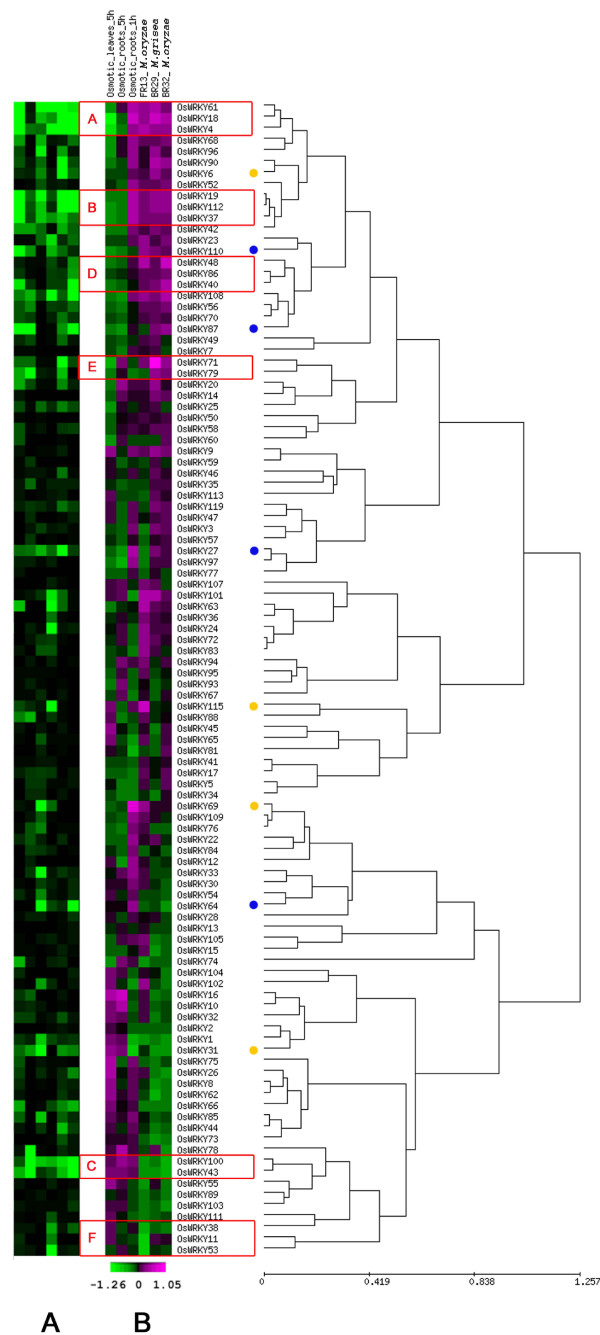
Clustering of OsWRKY genes according to their expression profiles in the OsWRKYARRAY. The OsWRKYARRAY was constitued of 104 probesets representing all members of the rice WRKY gene family. The expression of the 104 OsWRKY genes was assessed upon inoculation with Magnaporthe oryzae isolate from rice (FR13), M. oryzae BR32 from wheat, M. grisea BR29 from crabgrass and upon application of osmotic stress (mannitol) in hydroponic conditions. Panel A T-test P-values (shown by a green - black gradient) of treated vs control of the corresponding ratios shown in Panel B. The range of log transformed P-values comprised values between 0.01 (green) and 1 (black). P-values lower than 0.01 were visualized as 0.01. Panel B log2(Treated/Control) ratio values (shown by a green - magenta gradient). Red boxes with capital letters from A to F highlight the presence of co-expressed WRKY gene clusters. A blue dot indicates a OsWRKY gene differentially-regulated in two different stress conditions; a yellow dot indicates a OsWRKY gene-differentially regulated only in one stress condition. See Table 1 for numeric values of differentially-regulated OsWRKY genes.